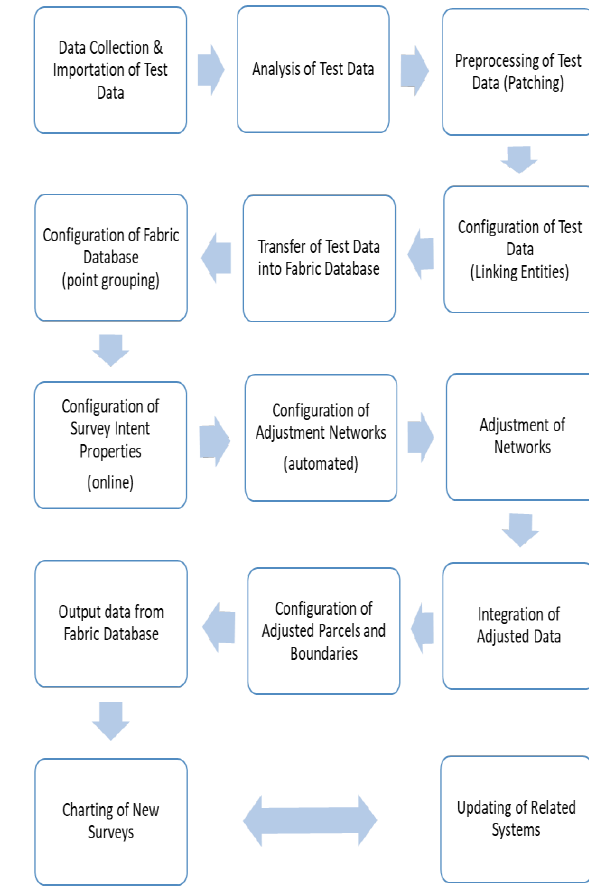
Figure 3. Cadastral Fabric Database Creation Process